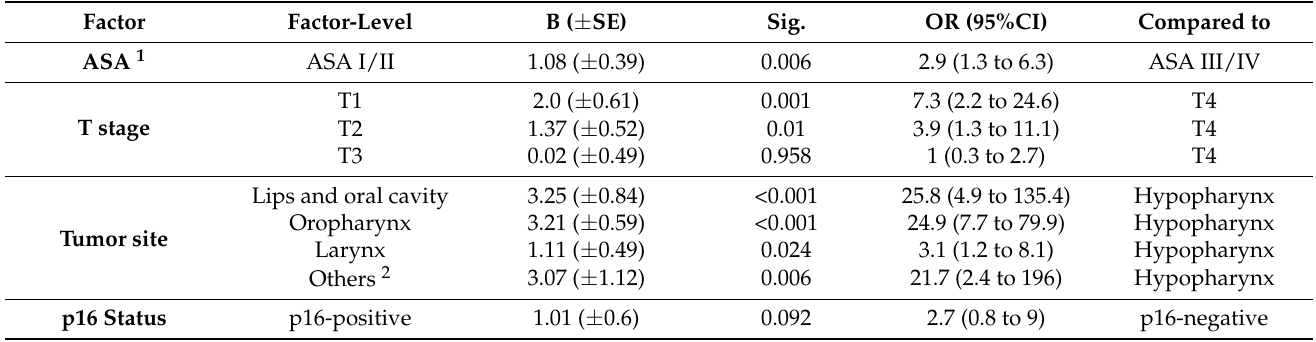
Table 4. Binary logistic model of factors influencing breathing in 416 patients with newly diagnosed HNC. Dependent variable was normal or near-normal breathing function (integrity score 3 and 4) vs. impaired breathing function (integrity score 0–2). Factors with p values < 0.2 in Chi-square tests were included. Odds ratios (OR) indicate the chance to achieve normal or near normal breathing function (the higher, the better).